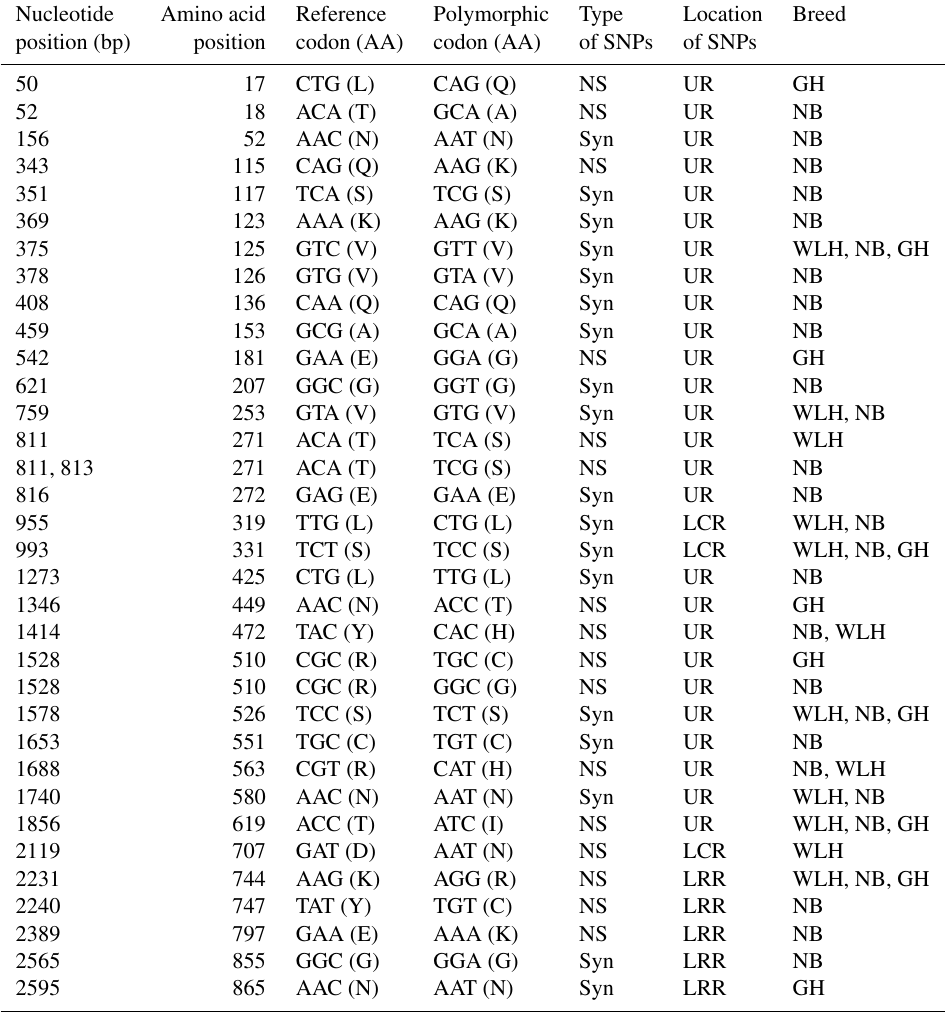
Table 6. Polymorphisms in the NOD1 gene of different chicken